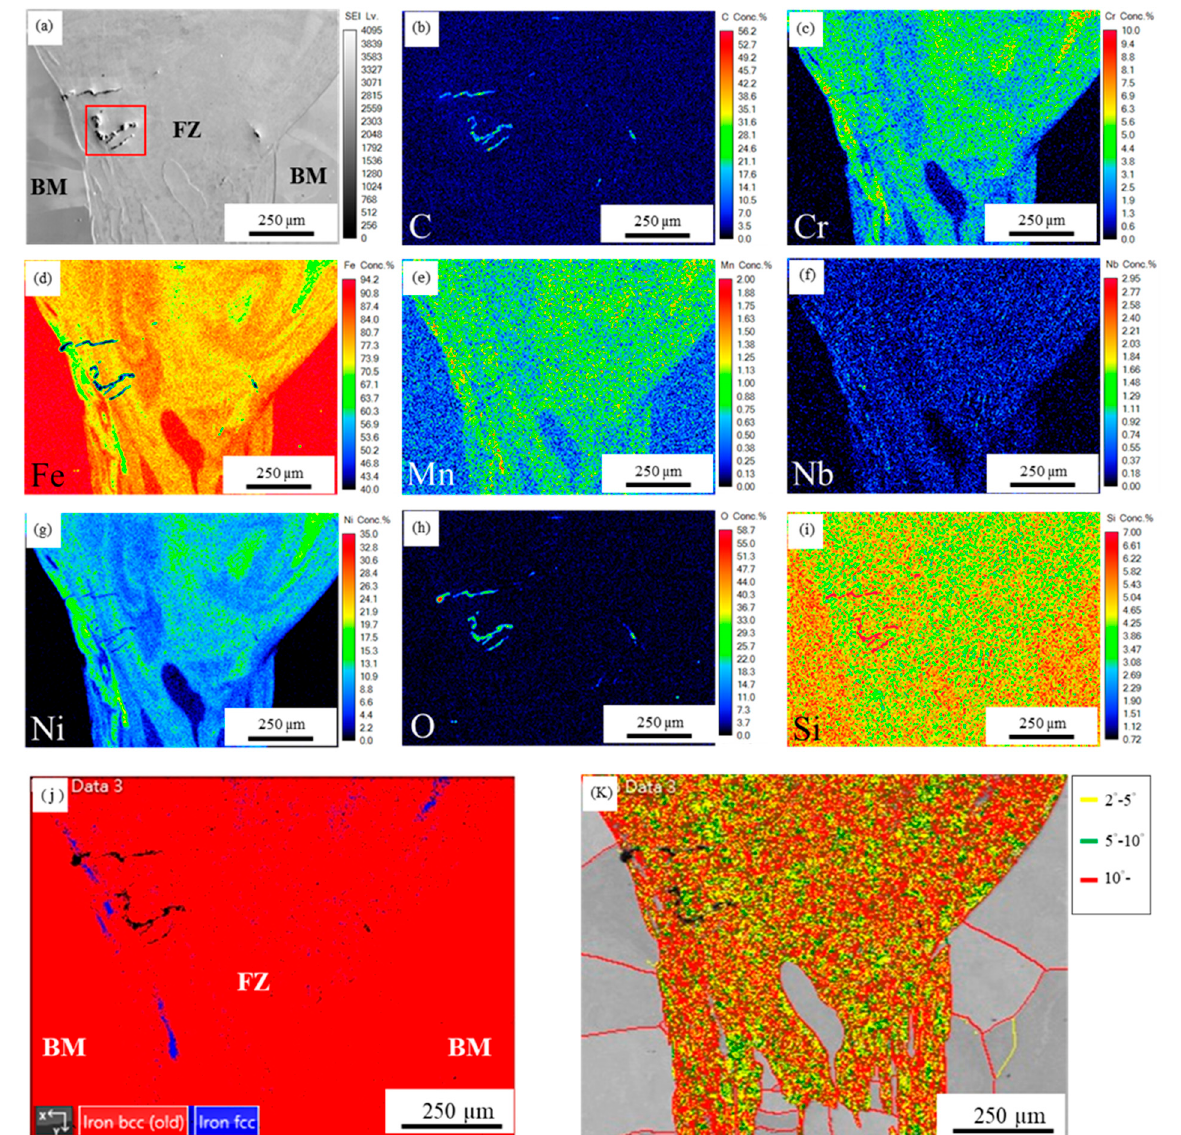
Figure 6. The cross section of the laser weldment with 1.2 m/min IN82 wire feeding rate: ( a ) EPMA SEI, ( b – i ) WDS quantitative mappings of C, Cr, Fe, Mn, Nb, Ni, O and Si in at%, ( j ) EBSD crystallographic map, ( k ) EBSD boundary misorientation map.